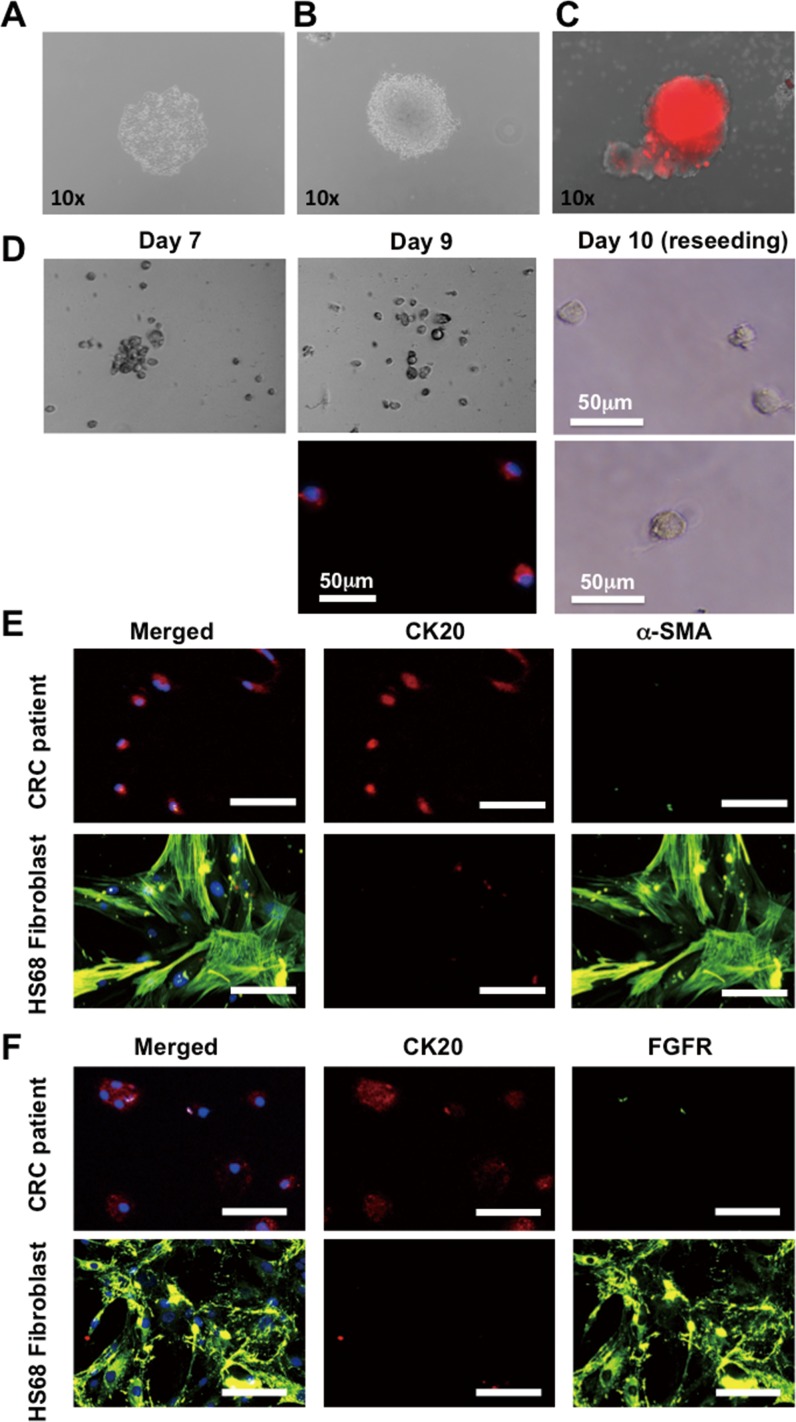
Cultivation of viable eluted CTCs.Capture and release of HCT116 cancer cell from CMx platform for further cultivation under (A) complete DMEM medium, (B) SPH culture medium, (C) suspension culture with SPH medium. (D) CTCs isolated from a stage III CRC patient. The cells gathered and attached to the bottom of culture plate at day 7 and became more spread out at day 9. Cells exhibited CK20+ (red) and nuclei+ (blue) with a size around 25μm. To prove these cells have a propensity to re-attach, they were treated with 0.1% trypsin and re-seeded at day 9. After 1 day, these cells re-attached to the substrate firmly (day 10). (E and F) Immunocytochemistry stain for the confirmation of colorectal origin of patient-derived CTC primary cultured cells. The skin-derived fibroblast cell line HS68 was used as negative staining control (blue: DAPI; red: CK20; green: α-SMA or FGFR).